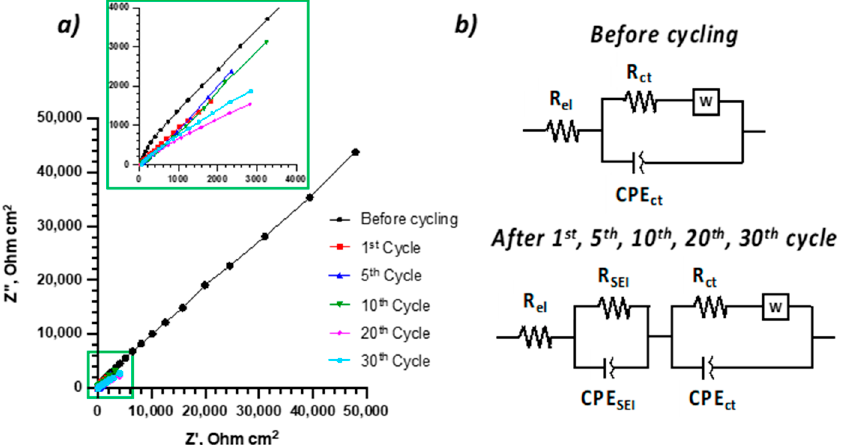
Figure 5. ( a ) Nyquist plots after predetermined CV cycle number; ( b ) determined equivalent circuits of the system. Table 2. Impedance spectra equivalent circuit element values after different CV